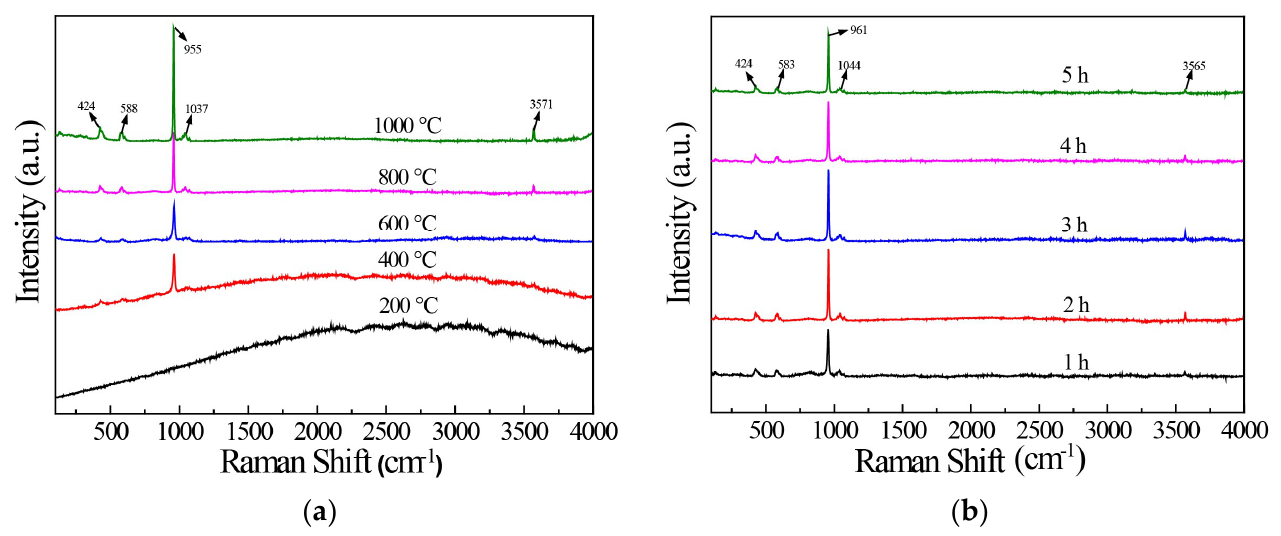
Figure 3. Raman diagram of HAP prepared at different calcination temperatures ( a ) and calcined for different time ( b ).